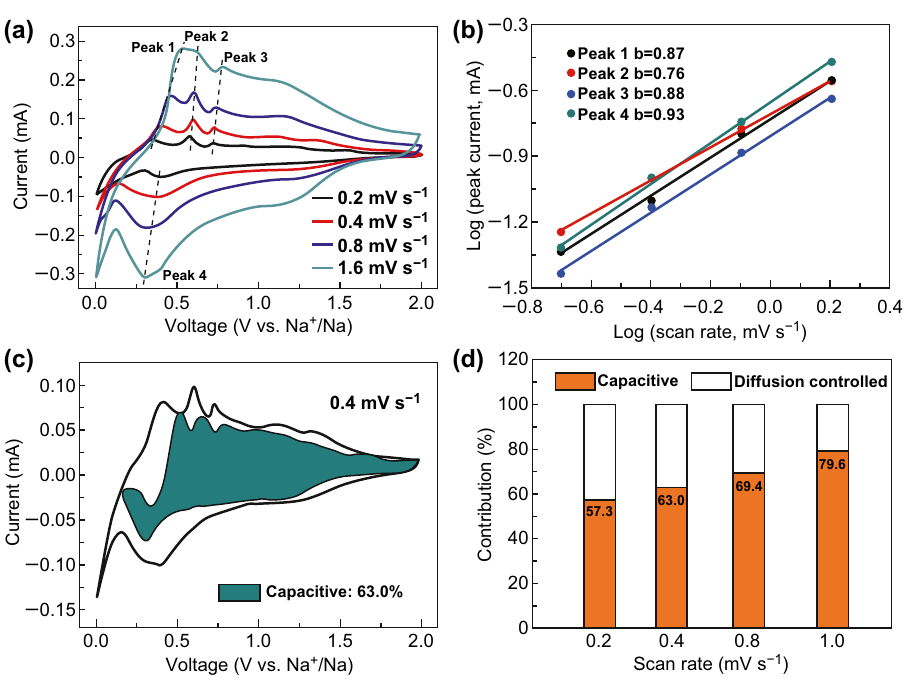
Fig. 5 a CV profiles of Sn/NS‑CNFs@rGO at various scan rate. b Plots of (log i ) versus (log υ ). c Capacitive contribution in the CV curve (shaded region) of Sn/NS‑CNFs@rGO obtained at 4 mV s −1 . d Capacitive contribution in the CV profiles obtained at various scan